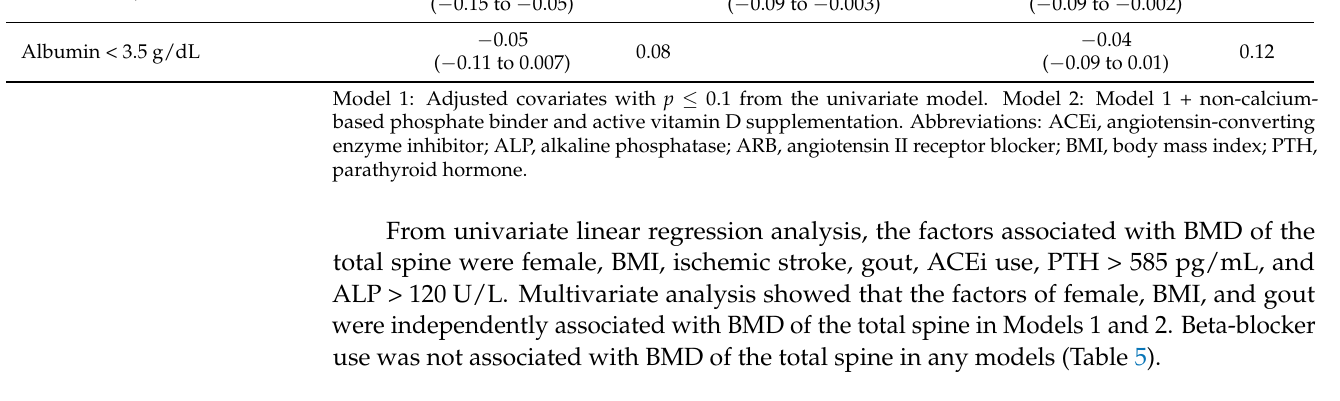
Table 5. Association of beta-blocker use and BMD of the total